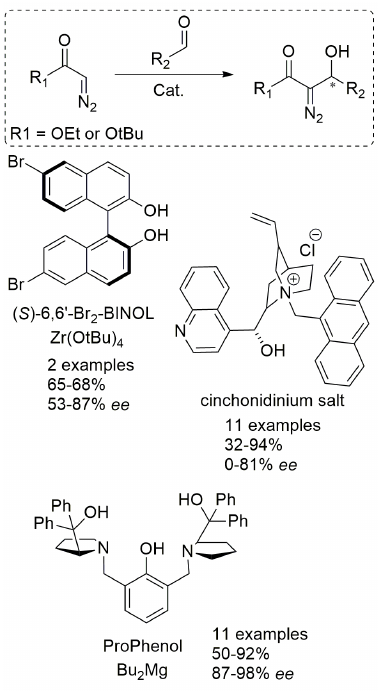
Figure 52 - Asymmetric aldol reaction of diazoketoesters.